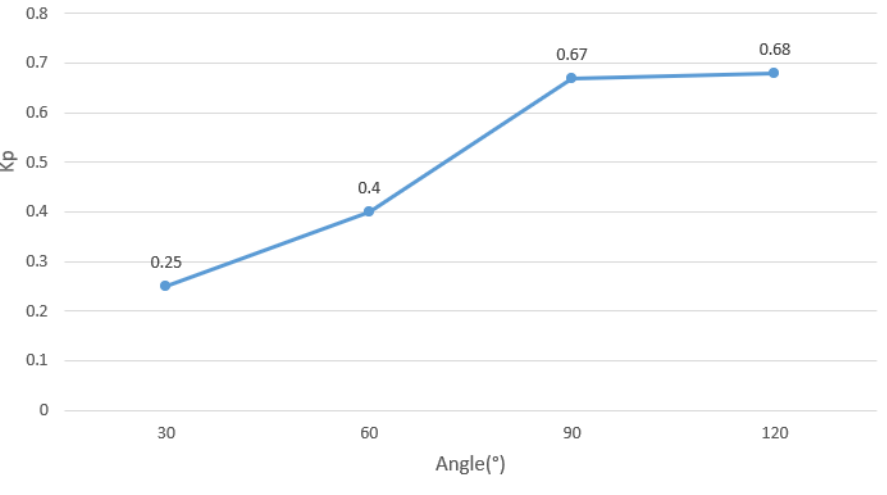
Figure 23. K p results as a function of corner